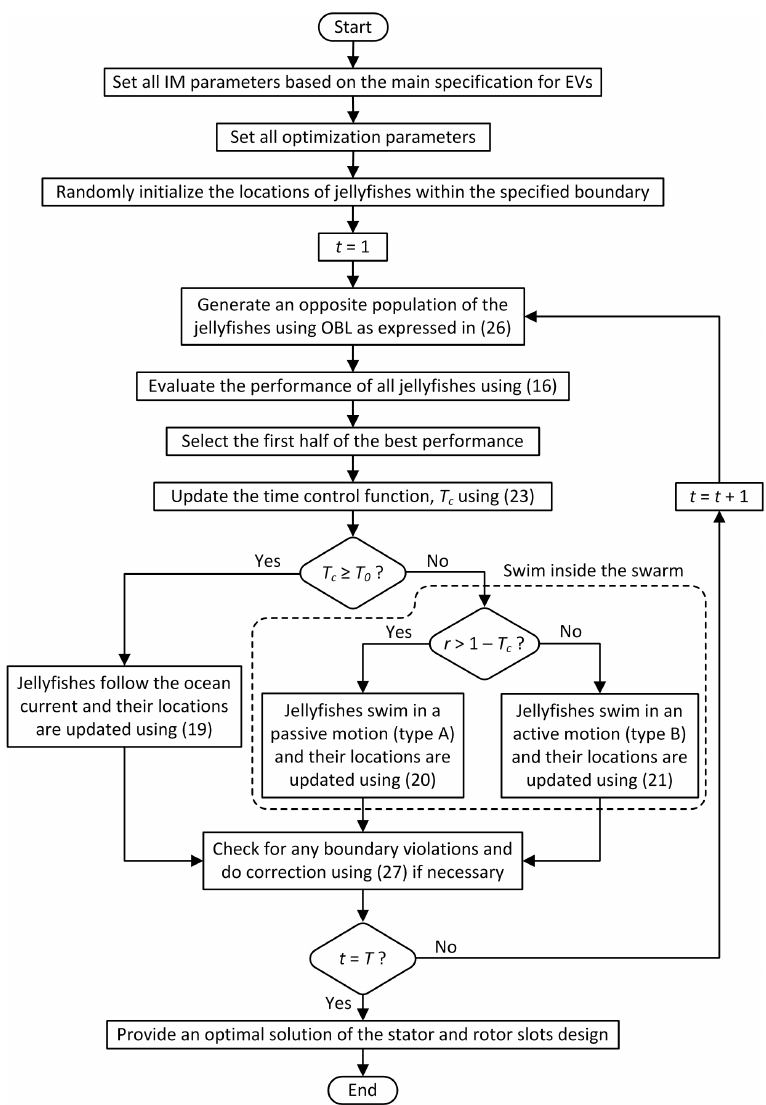
Figure 4. Flowchart of OBJSO for optimal stator and rotor slots